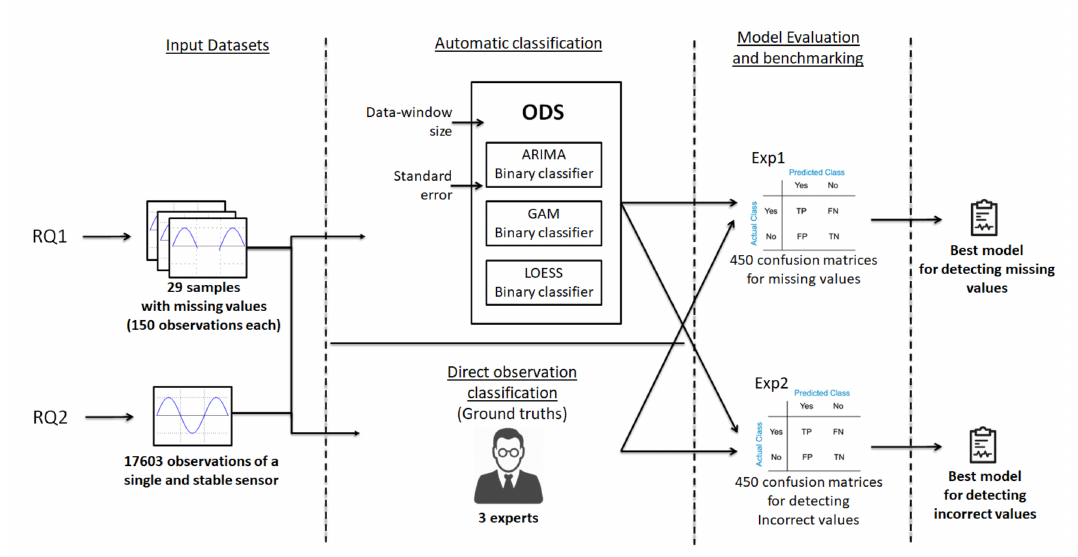
Figure 3. Experimental analysis